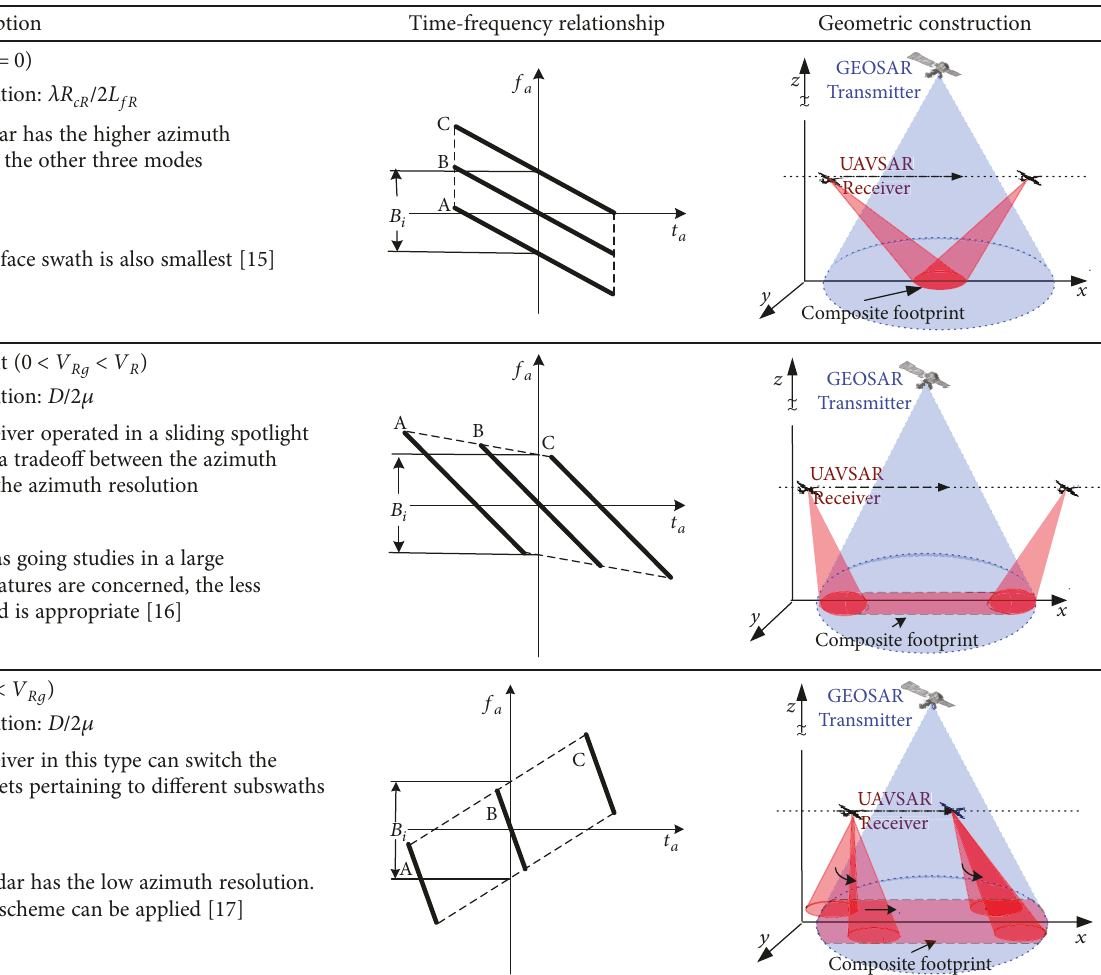
Table 1: The geometrical con fi guration of the GEO-UAV BiSAR. The time-frequency of received signals is plotted from three-point targets in near range (a), center range (b), and far range (c). B represents the instantaneous signal bandwidth. i Mode &